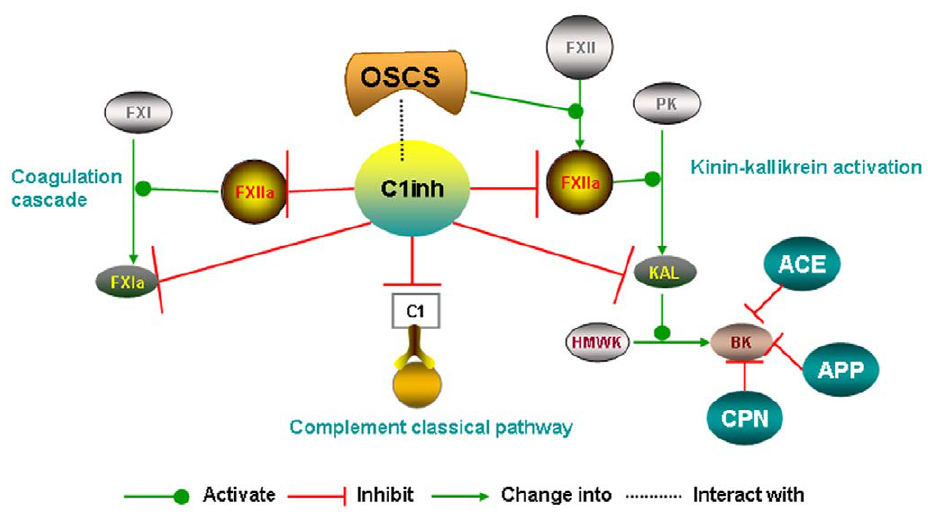
Figure 6. Factors that can influence bradykinin levels. The level of bradykinin (BK) is determined by the levels of kallikrein (KAL), high molecular weight kininogen (HMWK) and enzymes that degrade BK, such a angiotensin converting enzyme (ACE), aminopeptidase P (APP) and neutral carboxypeptidase (CPN). Activated factor XII (FXIIa) generates KAL from prekallikrein (PK). C1 inhibitor (C1inh) can inhibit both FXIIa and KAL. OSCS can facilitate FXIIa activity through enhancing its generation from FXII and/or stabilizing a complex of FXIIa, PK and HMWK. OSCS may also have a direct effect on C1inh. Other factors in the complement pathway and coagulation cascade can interact with C1inh and thus decrease C1inh availability for limiting BK